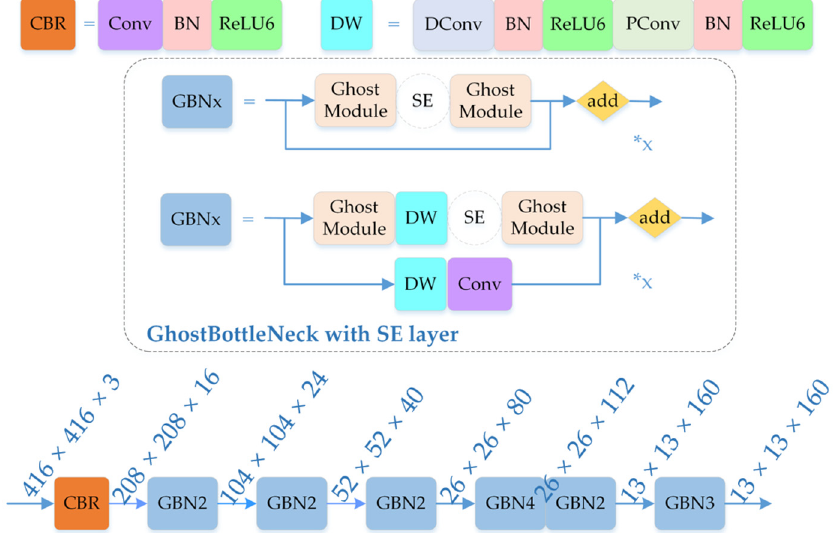
Figure 7. Diagram of GhostNet structure without fully connected layers. The ReLU activation function is used in Ghost Module. The symbol “*x” indicates the GBNx is composed of x GBN structures.